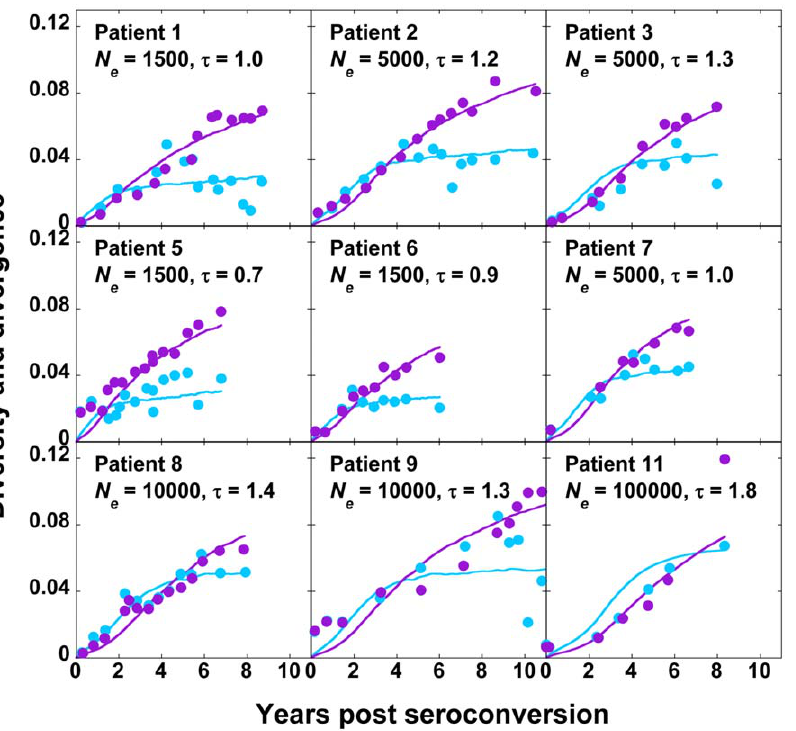
Figure 7. Fits of our simulations to data from patients. Best-fit predictions of our simulations (solid lines) presented with experimental data (symbols) of the evolution of viral diversity, d G , (cyan) and divergence, d S , (purple) for each patient. Each cell is assumed to be infected with M virions drawn from a distribution based on a viral dynamics model (see text). The values of N e (cells) and t (days) employed for the predictions are indicated.